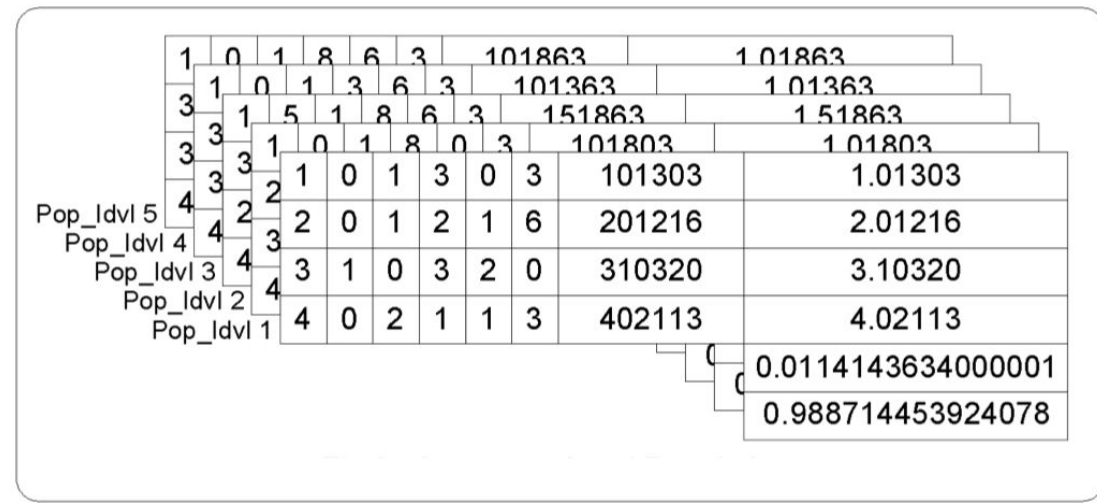
Figure 2: Structure of total Population